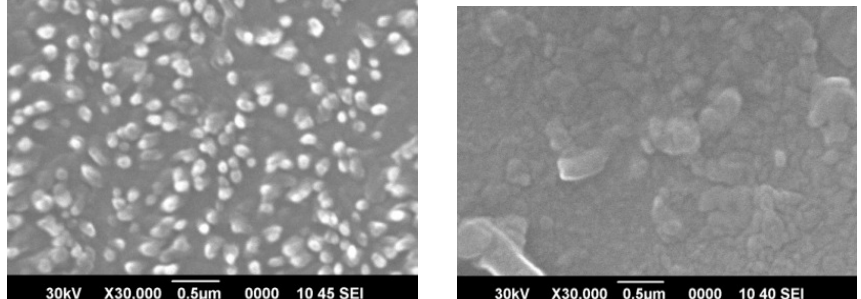
Figure 7. (a) and (b) SEM images of as-deposited and annealed at 473 K in vacuum